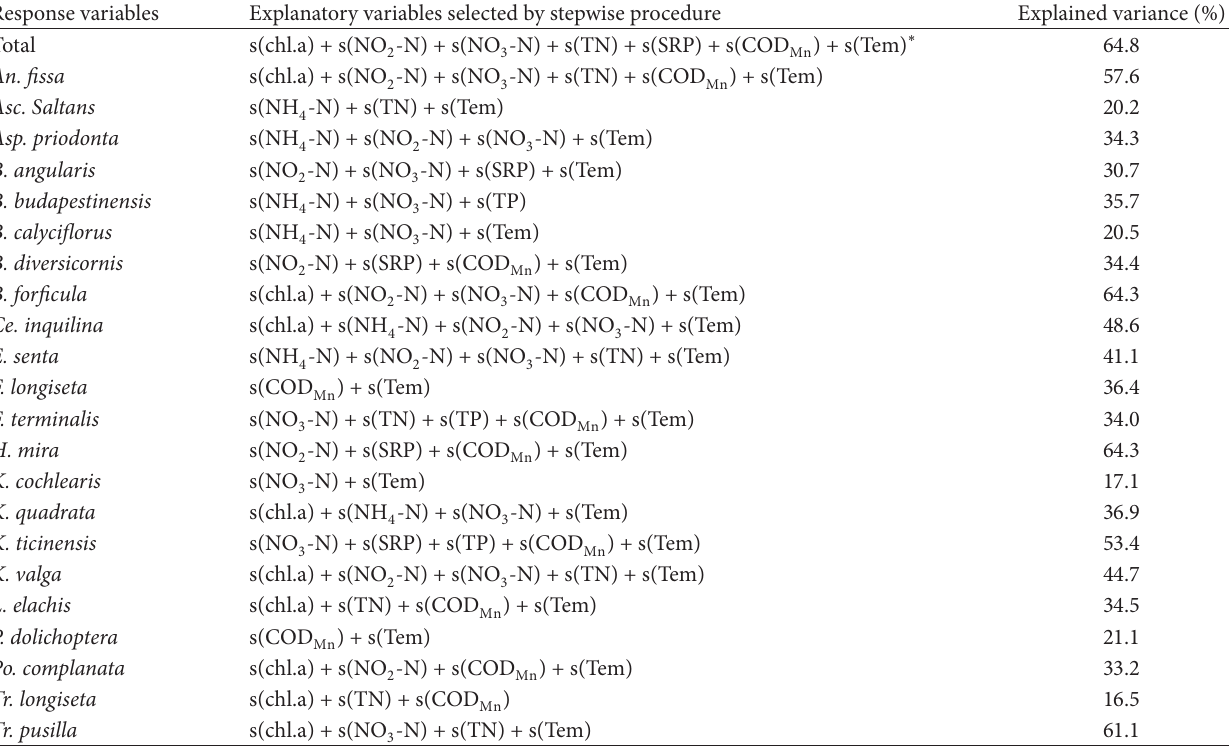
Table 3: GAMs generated by the forward and backward stepwise selection